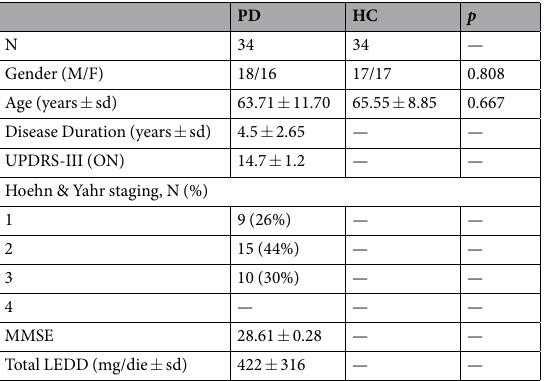
— Table 1. Demographic, clinical and cognitive features of the study groups. Abbreviations: HC, healthy controls; LEDD, Levodopa equivalent daily dose; MMSE, Mini-Mental State Examination; PD, Parkinson’s disease patients; UPDRS-III, Unified Parkinson’s Disease Rating Scale- motor